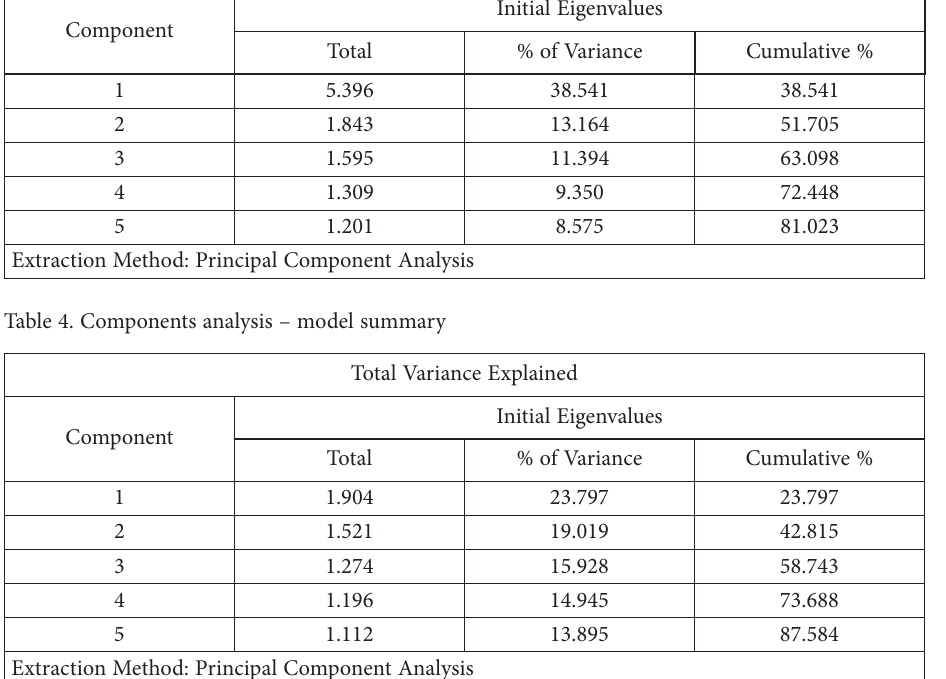
Total Variance Explained